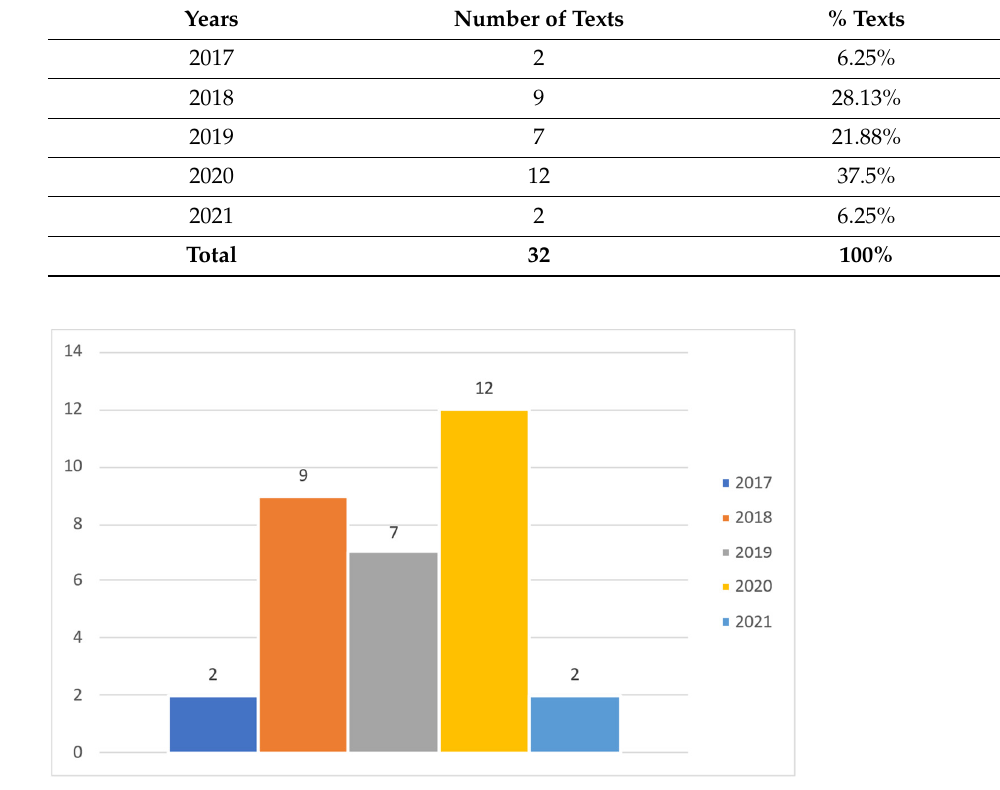
Figure 8. Number of Authors per Journal.